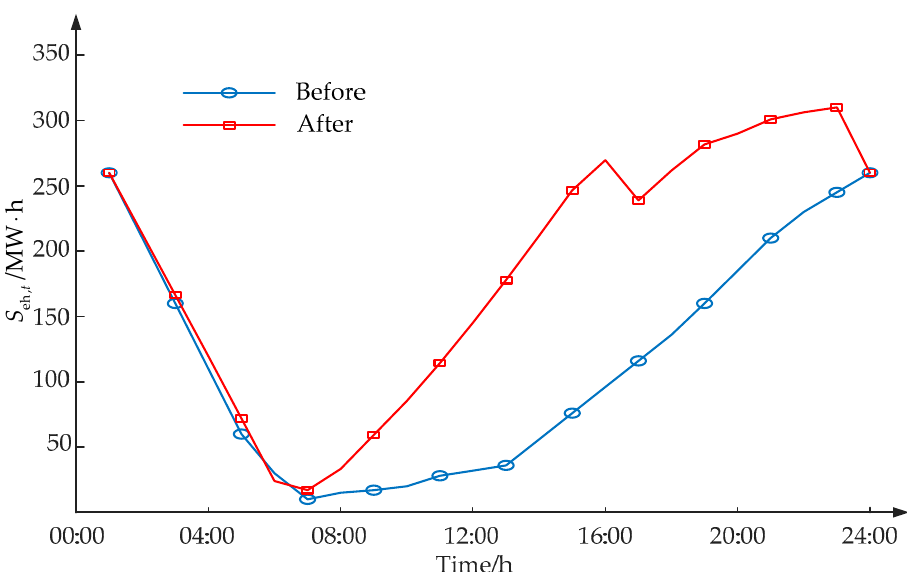
Figure 12. The changes in heat storage of HSD before and after considering temporal dependence.